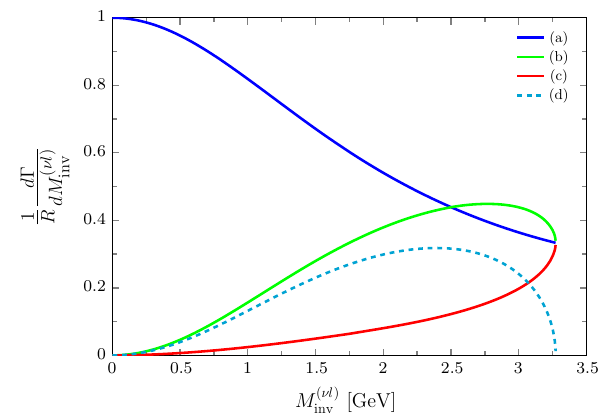
Fig. 4 The same as Fig. 3 but for different ratios. The lines (a), (b) and(c)show d Γ and line (d) denotes the difference of d Γ divided by the total differential width R of Eq.